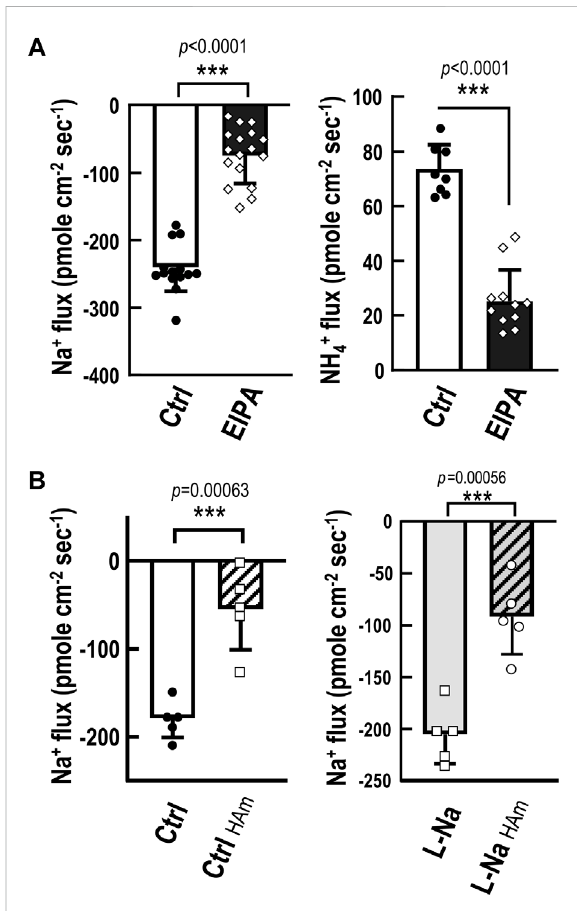
FIGURE 4 Functional characterization of NHE-mediated Na + uptake/ NH 4 + excretionmachinery.Na + andNH 4 + fl uxesattheionocytesin medaka yolk skinweremeasured bySIET. (A) , Treatment with 0.1% 5-ethylisopropylamiloride(EIPA;anNHEinhibitor)for10 min suppressed both Na + in fl ux and NH 4 + ef fl ux at the ionocytes compared with the control group (Ctrl). (B) , Acute exposure to 5 mM NH 4 + (HAm) suppressed ionocyte Na + in fl ux in embryos acclimated to low-Na + (0.01 mM, L-Na) or control freshwater (1.02 mM, Ctrl) for 7 days. Data are presented as mean ± SE. Asterisksindicatesigni fi cantdifferenceof p < 0.001(***)(Student ’ s t